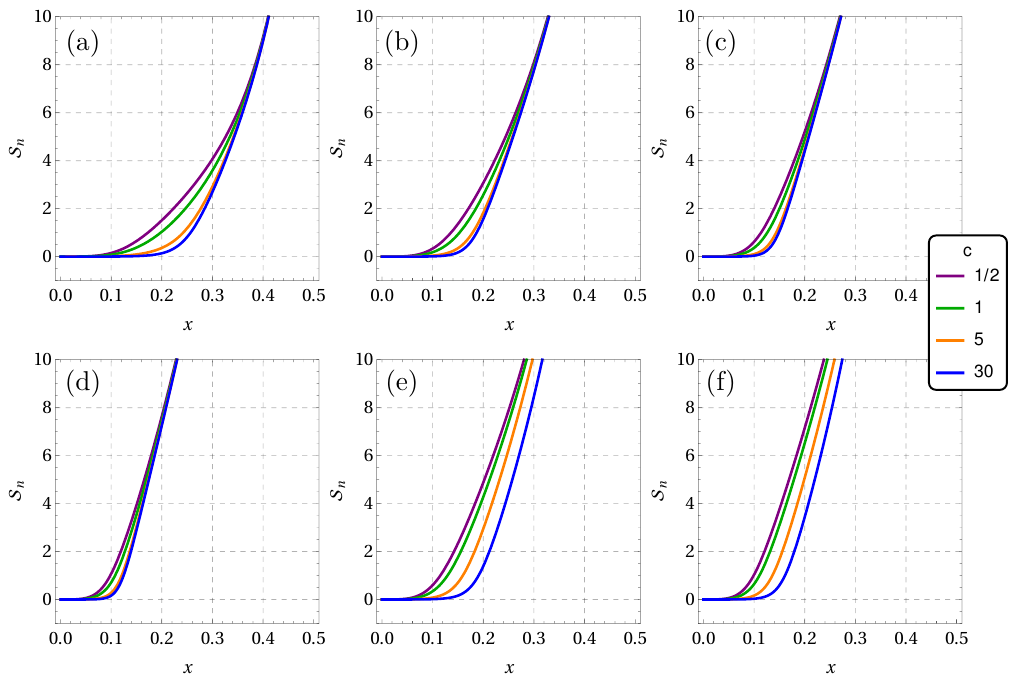
Figure 4 . The Sandwiched Rényi Divergence for n = 2 between the reduced groundstate and (a) L − 2 | 0 i , (b) L − 3 | 0 i , (c) L − 4 | 0 i , (d) L − 5 | 0 i , (e) L 2 central charge c